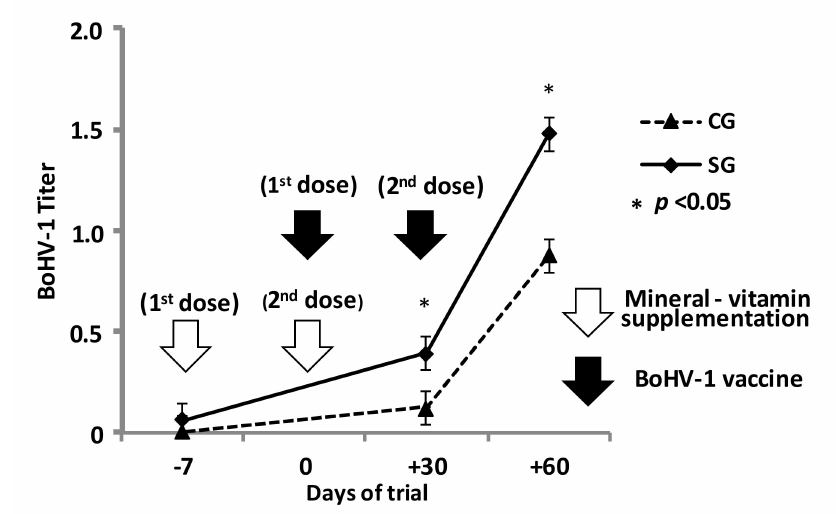
Figure 1. Log-transformed titer responses to BoHV-1vaccine in weaning calves (n = 10 per group). SG, supplemented group (1 mL / 50 kg containing 10 mg% Cu, 40 mg% Zn, 0.5 mg% Se, 10 mg% Mn, 3.5% retinol palmitate and 5.0 % vitamin E acetate on days − 7 and 0); CG, control group (saline sterile solution on days − 7 and 0). SG and CG were vaccinated with inactivated BoHV-1 on days 0 and +